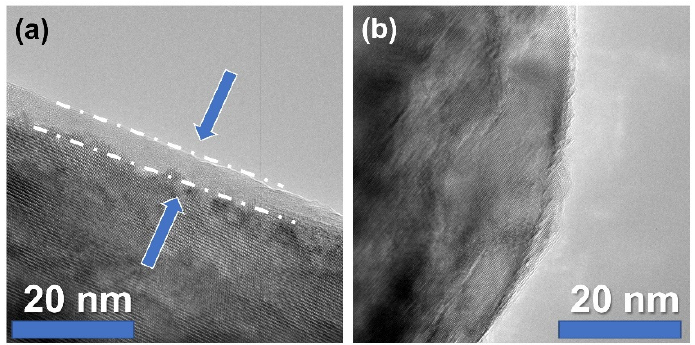
Figure 4. TEM observations of an AlN grain. The arrow points to a nanosized-thick amorphous layer. ( a ) AlN particle with amorphous layer, ( b ) AlN particle without amorphous layer.